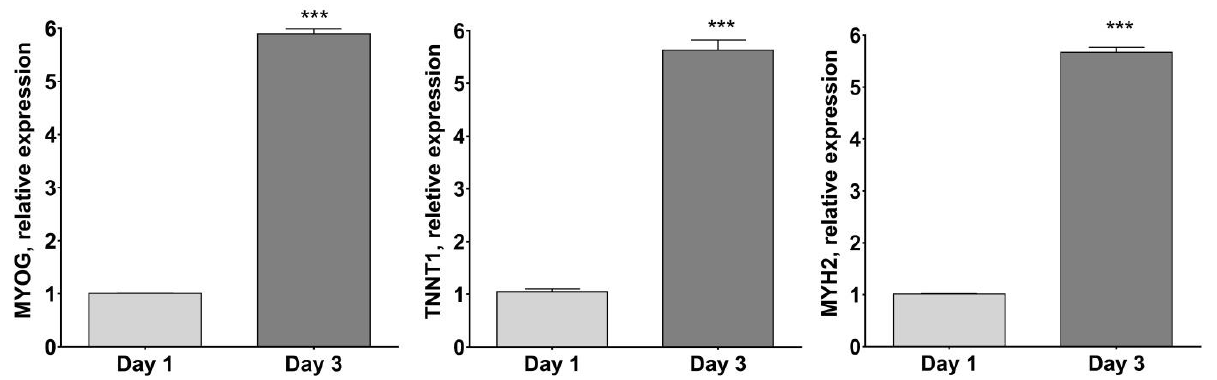
Figure 4. Skeletal muscle cell marker gene expression by RT-PCR. Plots show gene expression of late muscle cell markers Myosin heavy chain-2 (MYH2), Troponin T (TNNT1) and Myogenin (MYOG), normalized to three most stable reference genes, eEF1a, RPL13a and B2M, (Avg M value = 0.269) and then the 2 − ∆∆ Ct algorithm was applied for relative quantification. *** p < 0.001 vs. day 1 using Student’s t -test.